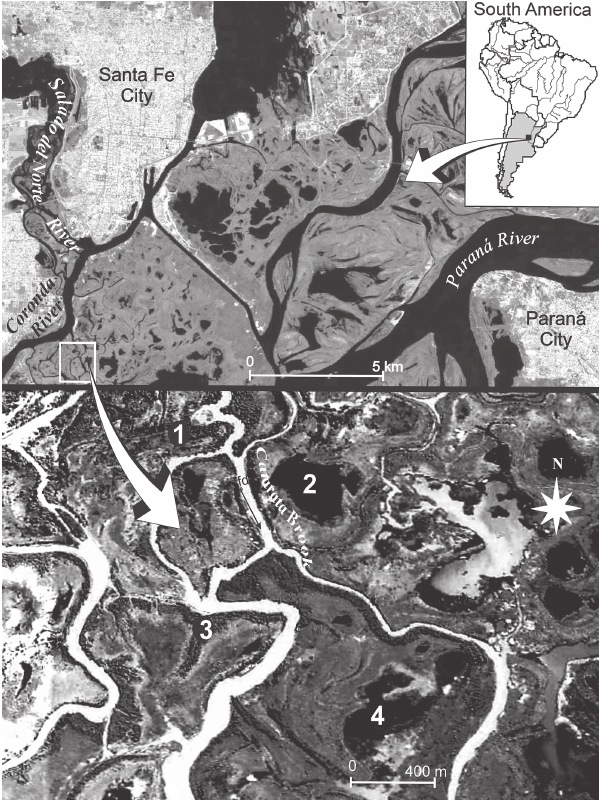
Fig. 1. Study area in the alluvial plain of the Paraná River and sampling sites (1 and 3: lotic habitats; 2 and 4: lentic habitats) located in the Catarata brook; fd=flow direction-modified from Espínola et al . (2014).